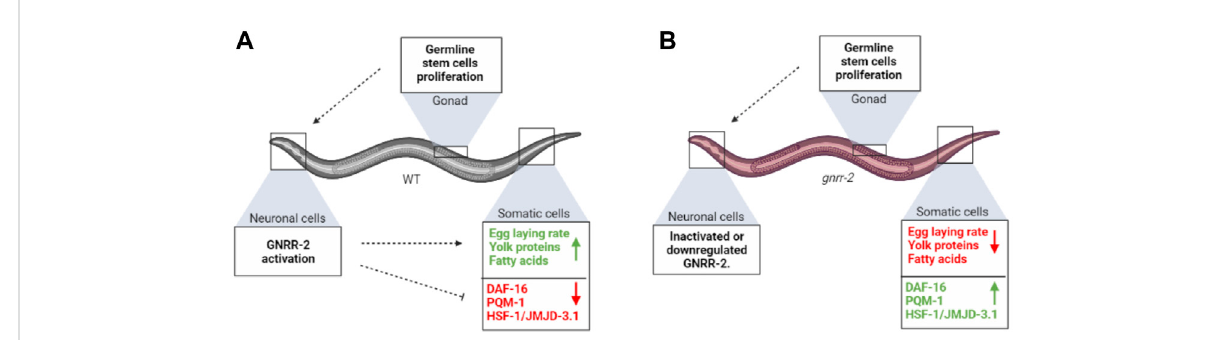
FIGURE 6 gnrr-2 mediates signals from the reproductive system to the soma. (A) At the onset of WT oogenesis, gonadal signaling reports on GSCs ’ competencetoneuronal gnrr-2 ,whocoordinatelyactivatesorrepressesvarioustranscriptionalprogramsinthesoma,inverselymodulatingsomatic maintenance and reproductive robustness. (B) Disrupting GNRR-2 function alters these signals, resulting in inhibition of proteostasis collapse and inhibition of somatic resources reallocation to the reproductive system. The fi gure was created using